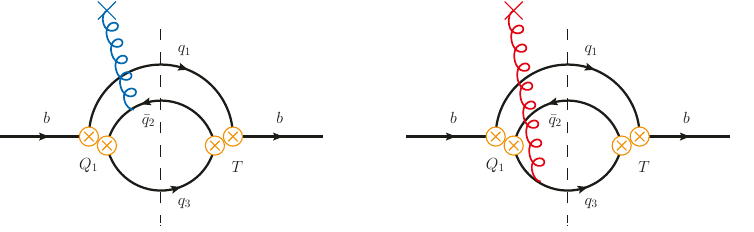
Figure 3 . The two-loop diagrams describing power corrections up to dimension-six from Q 1 ⊗ T